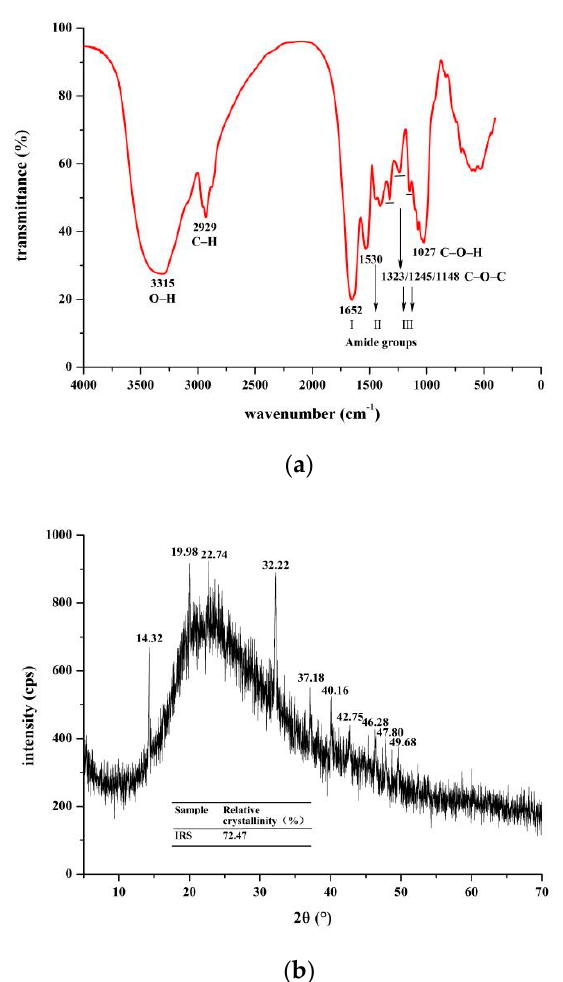
Figure 3. Fourier transform infrared spectroscopy (FT-IR, ( a )) and X-ray diffractometry (XRD, ( b )) results of IRS. The relative crystallinity was calculated by MDI Jade 6.0.